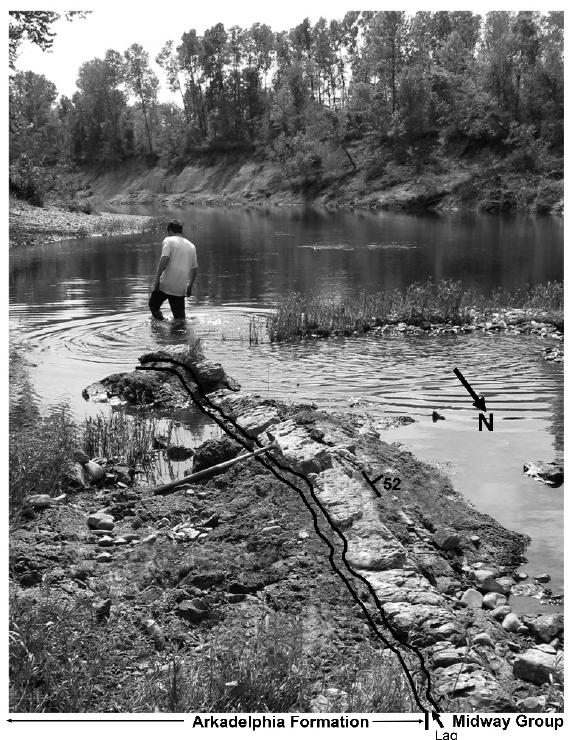
Figure 2. Outcrop exposure along the Ouachita River of the upper Arkadelphia Formation and basalmost Midway Group in Hot Spring County, Arkansas. Note strike and dip and steep inclination of the bedding relative to river water flow. Small arrow indicates the stratigraphic position of the lag deposit from which the turtle fossils in this study were recovered. Pick axe is approximately 1 m and the person is 1.8 m (Modified from Becker et al. [4]).